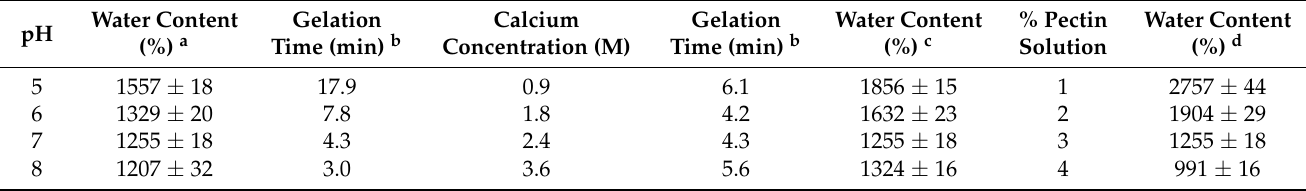
Table 1. Water content and gelation time of pectin hydrogel synthesized from various extrinsic